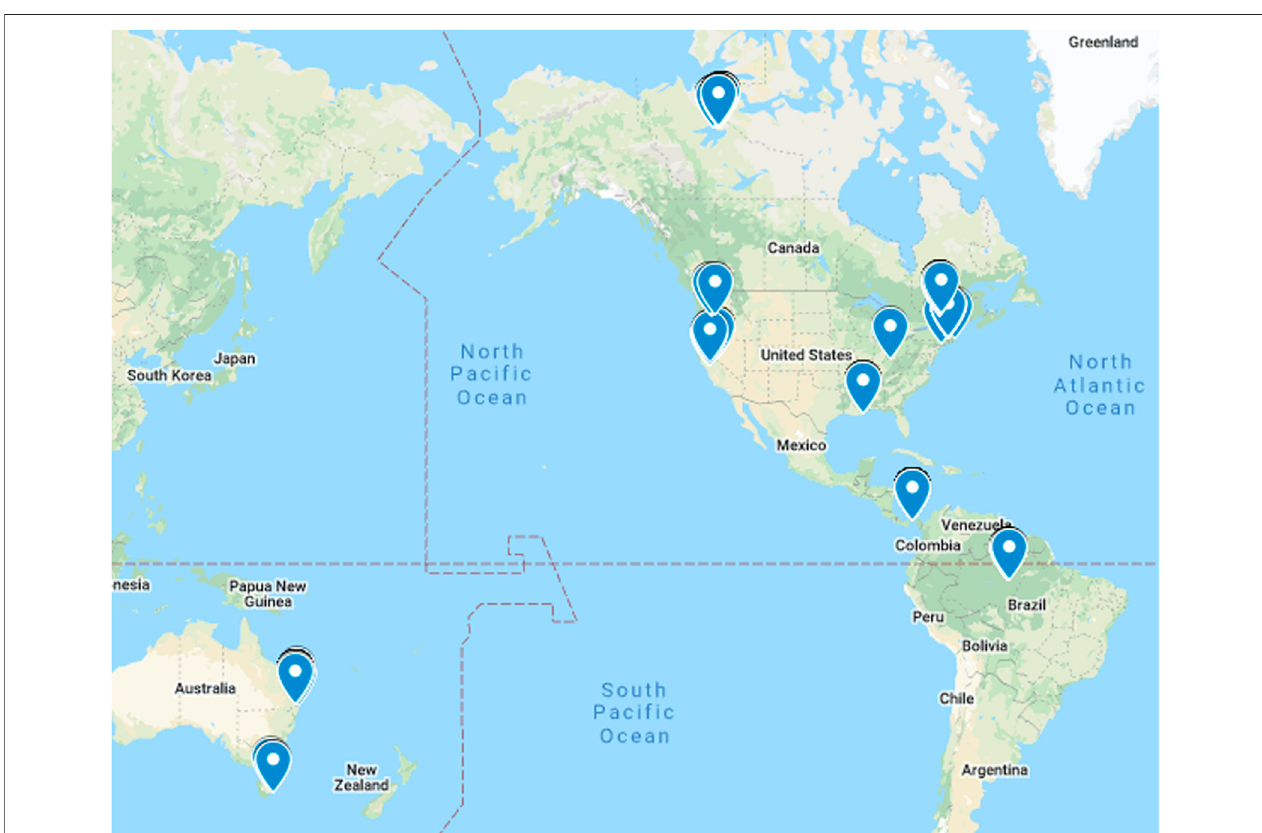
FIGURE 2 | Sampling sites used in this study.